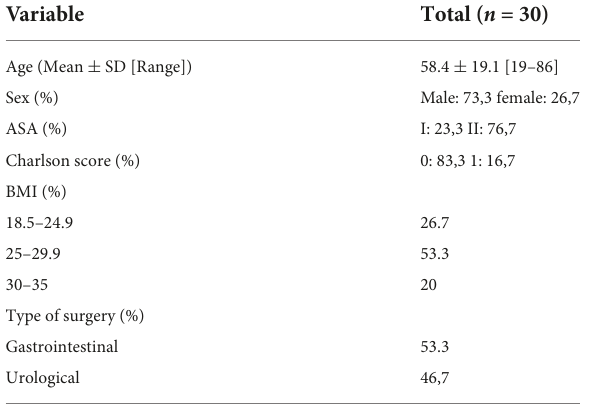
TABLE 1 Patients’ characteristics.